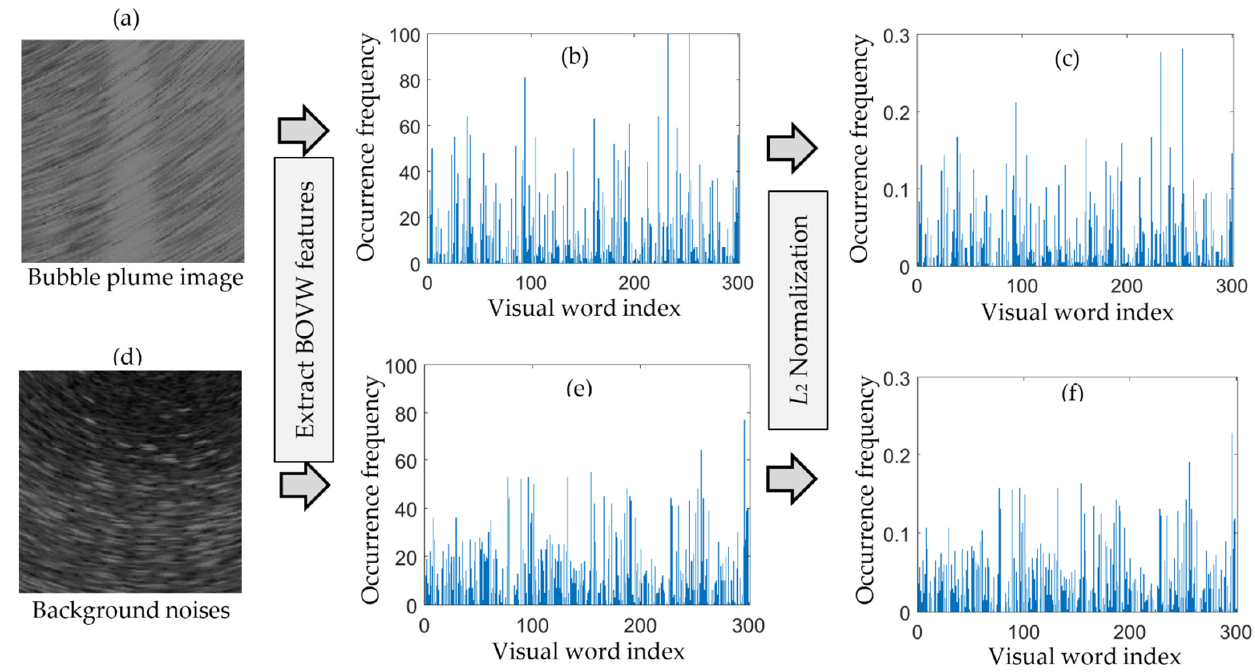
Figure 5. BOVW feature encoding of positive (( a ): bubble plume target) and negative (( d ): background noise) samples. ( b , e ) show occurrence frequencies of visual words extracted from ( a , b ), respectively. ( c , f ) are normalized from ( b , e ), respectively.